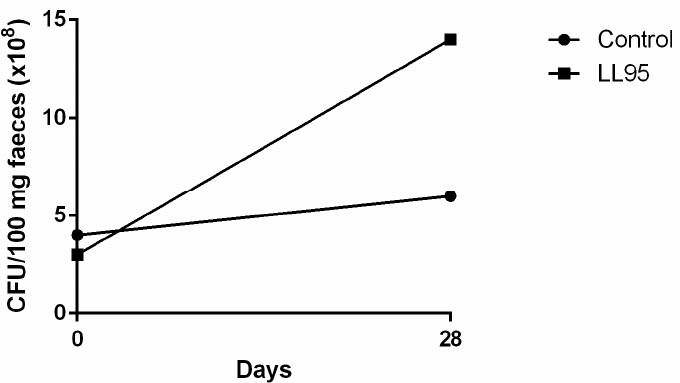
Figure 5. E ff ect of L. lactis LL95 on faecal content of LAB. The administration of L. lactis LL95 Figure 5. Effect of L. lactis LL95 on faecal content of LAB . The administration of L. lactis LL95 induced